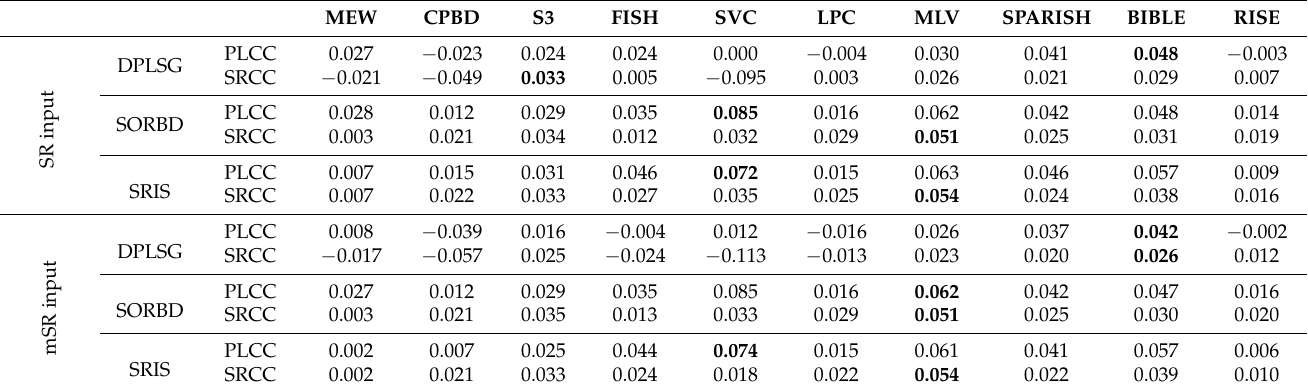
Figure 4. Absolute difference in predicted scores on CSIQ images based on the SORBD method combined with the SVC model. The images causing the three largest score drops are illustrated next to the points. (The figure can be enlarged for viewing). Table 1. Center region (CR) input as the baseline for BISA comparison on the